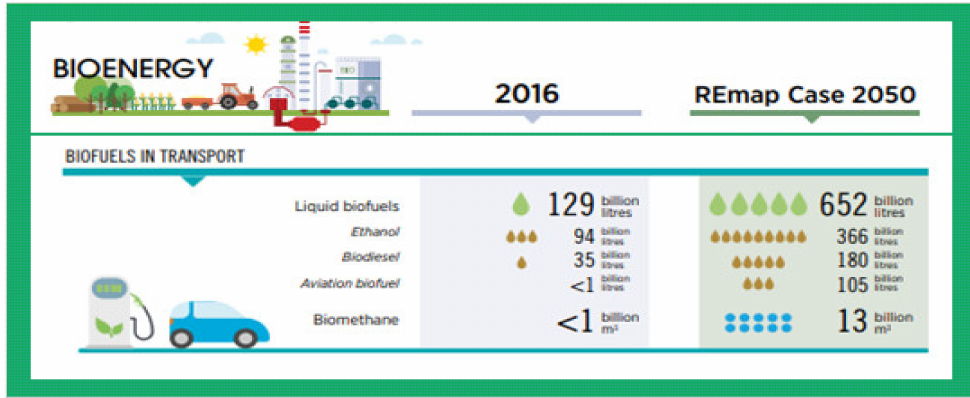
Figure 9. Biofuel in the transport sector, 2016 and 2050 scenarios. Adapted from [179]. Developed by the authors.